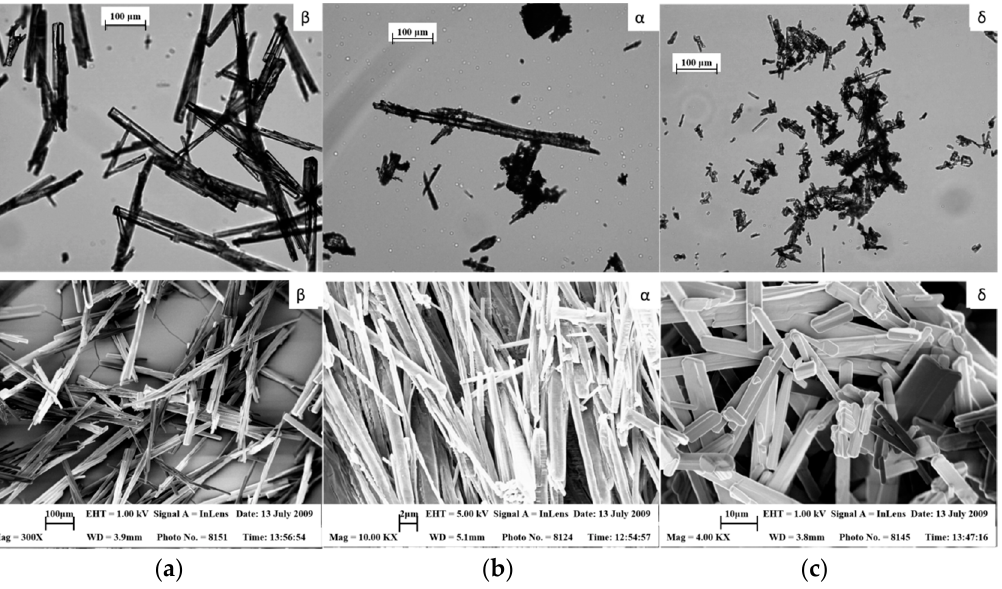
Figure 3. Optical microscope and SEM images of different mannitol polymorphs: ( a ) β form, ( b ) α form, and ( c ) δ form. Adapted with permission from Ref. [25]. Copyright 2010, American Chemical